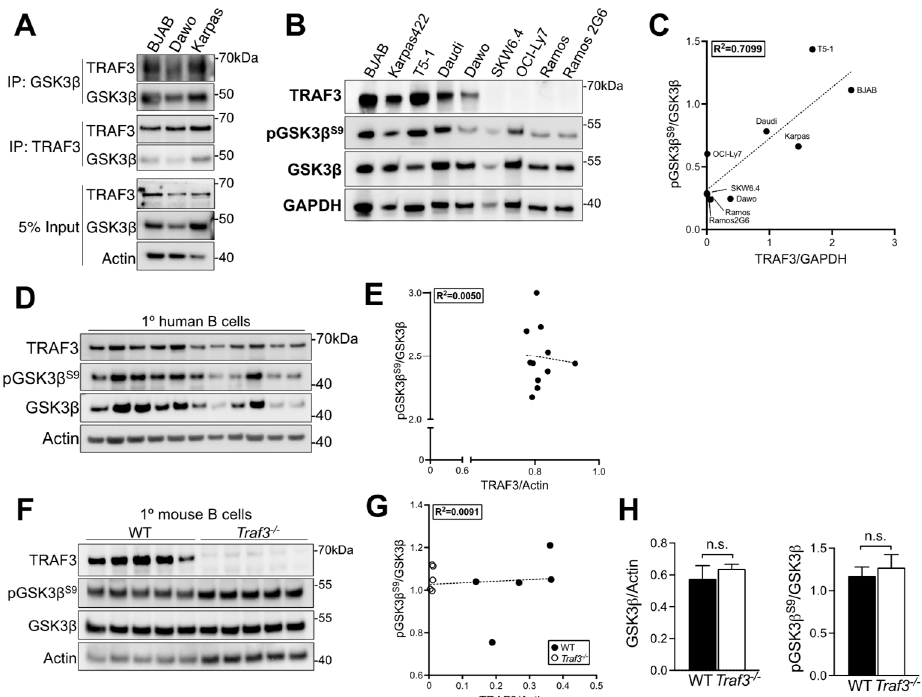
Figure 1. Relationship between TRAF3 status and inactive GSK3 β in B cell lymphoma cell lines. ( A ) Cells from BCL cell lines were lysed and GSK3 β or TRAF3 was immunoprecipitated. IP samples and input/whole cell lysate (WCL) were analyzed by Western blotting. ( B ) Representative blot of TRAF3, GSK3 β and pGSK3 β S9 in a panel of BCL cell lines. ( C ) Graph of amount of TRAF3 vs. ratio of inactive (pGSK3 β ):total GSK3 β from data in ( B ). ( D ) Western blot of human B cells from the peripheral blood of healthy donors. ( E ) Graph of amount of TRAF3 vs. ratio of inactive (pGSK3 β ):total GSK3 β from data in ( F ). Representative Western blot of pGSK3 β S9 and total GSK3 β in primary mouse B cells from mice with or without a B cell-specific TRAF3 deficiency. ( G ) Graph of amount of TRAF3 vs. ratio of inactive (pGSK3 β ):total GSK3 β from data in ( F ). ( H ) Quantification of blots in ( D ). Blots are representative of at least 3 independent experiments ( A , B ). In ( C ), each lane represents an individual human donor. In ( D ), each lane represents an individual mouse. n.s., not significant